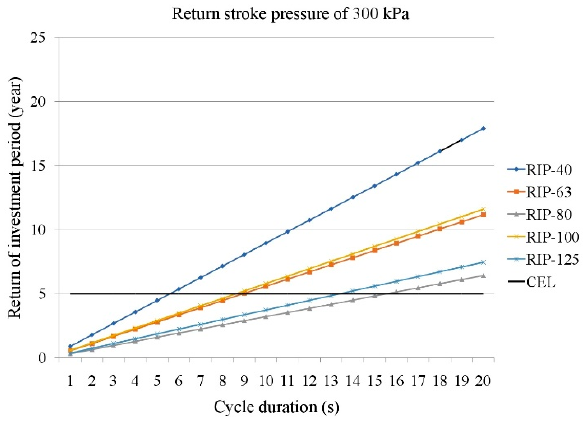
Figure 8. Return of investment period (RIP) with return stroke pressure of 300 kPa.